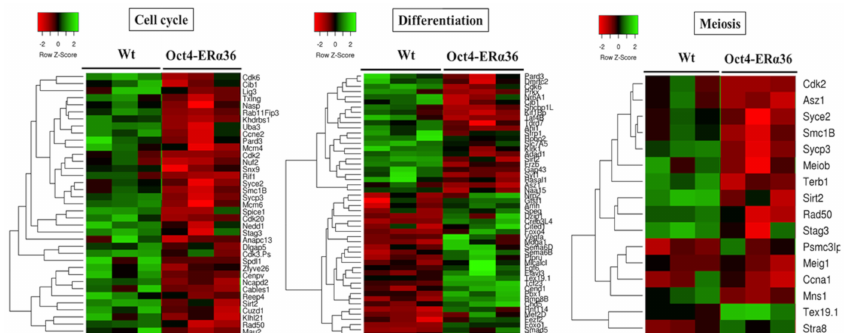
Figure 3. The main biological processes a ff ected by ER α 36 expression in mouse fetal testis. Heatmaps showing the expression level of di ff erentially expressed genes involved in «Cell cycle», «Di ff erentiation» and«Meiosis»processesinOct4-ER α 36C57BL6 / Jtransgenicmicecomparedtowild-typeones. Cellcycle: 37 genes; Di ff erentiation: 51 genes and Meiosis: 16 genes. Red: down regulated genes vs. green: up-regulated genes. For each experimental condition, 3 biological replicats of independent fetal gonad pools are